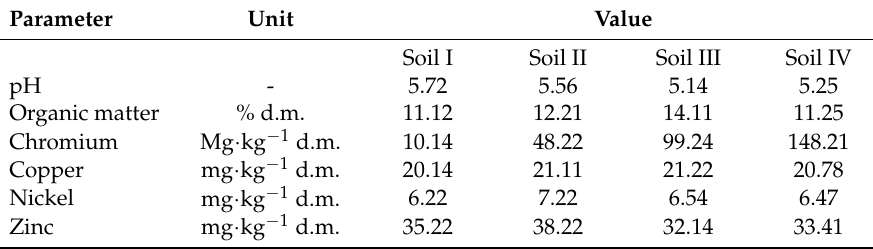
Table 1. Selected parameters of the soil used in the phytostabilization experiment.